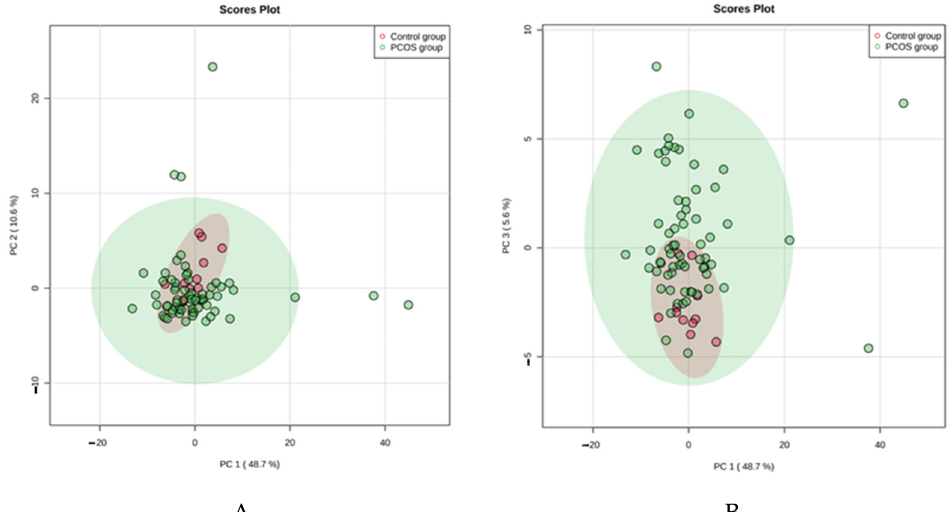
Figure 1. The unsupervised multivariate principal component analysis (PCA) of the studied metabolites in the PCOS and control groups. The plots represent the first principal component (PC1) against the second principal component (PC2) ( B ) and the first principal component (PC1) against the third principal component (PC3) ( A ).